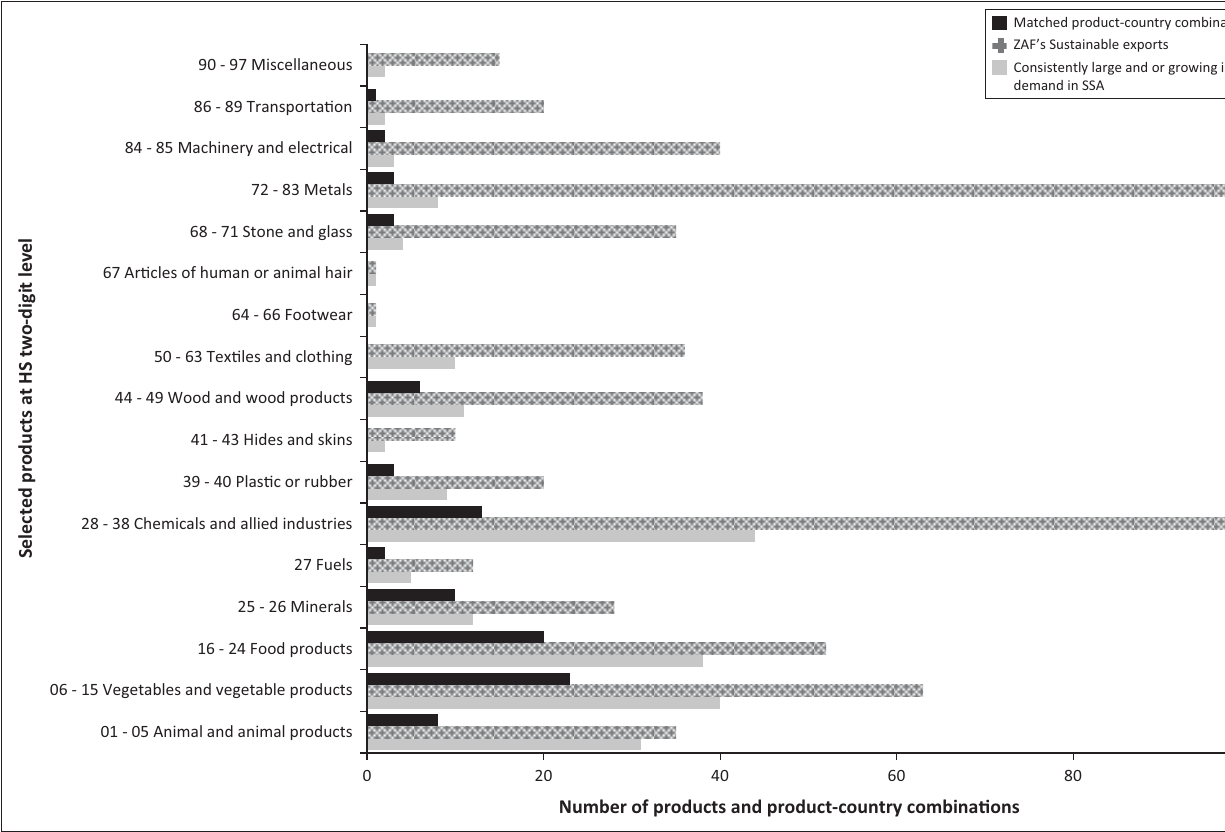
Number of products and product-country combina(cid:12)ons FIGURE 3: Comparison of results obtained in Steps 1.1, 1.2 and 2 at Harmonised System (HS) two-digit level.